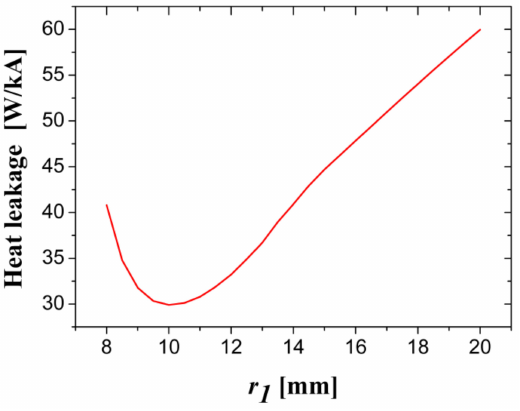
Figure A9. The effect of radius of the copper leads r 1 on the cold end heat leakage of